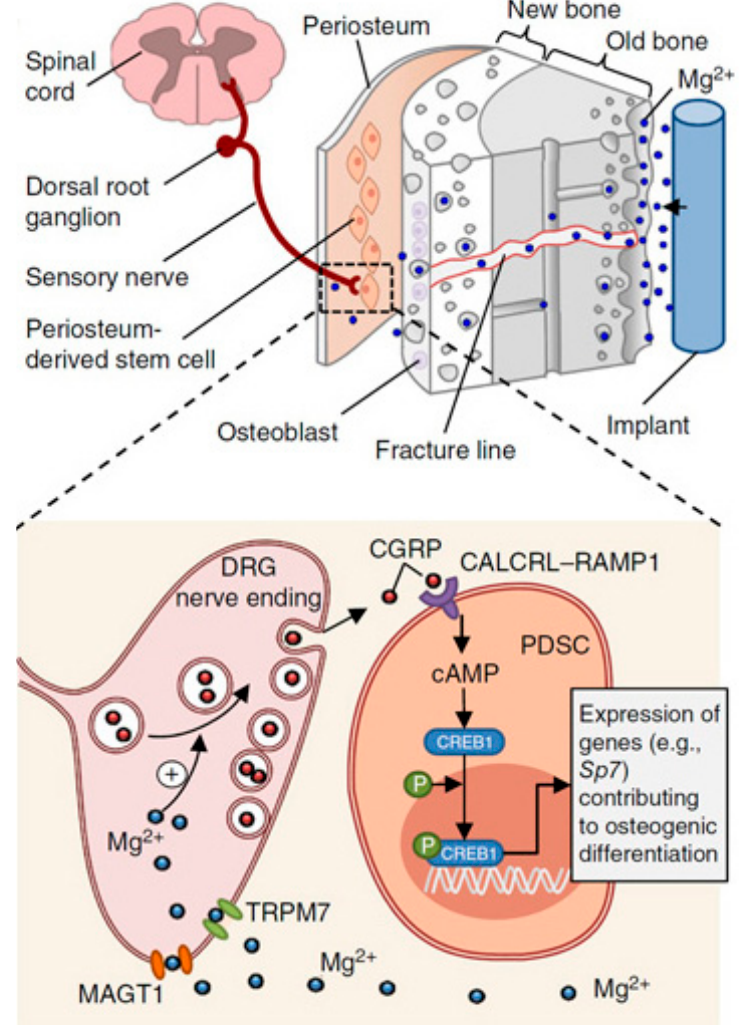
Figure 1. Schematic diagram of the mechanism of magnesium ions for bones [33]. Reprinted from Nat. Med., 22, Zhang, Y.; Xu, J.; Ruan, Y.C.; Yu, M.K.; O’Laughlin, M.; Wise, H.; Chen, D.; Tian, L.; Shi, D.; Wang, J.; et al., Implant-Derived Magnesium Induces Local Neuronal Production of CGRP to Improve Bone-Fracture Healing in Rats, 1160–1169, 2016, with permission from Elsevier.